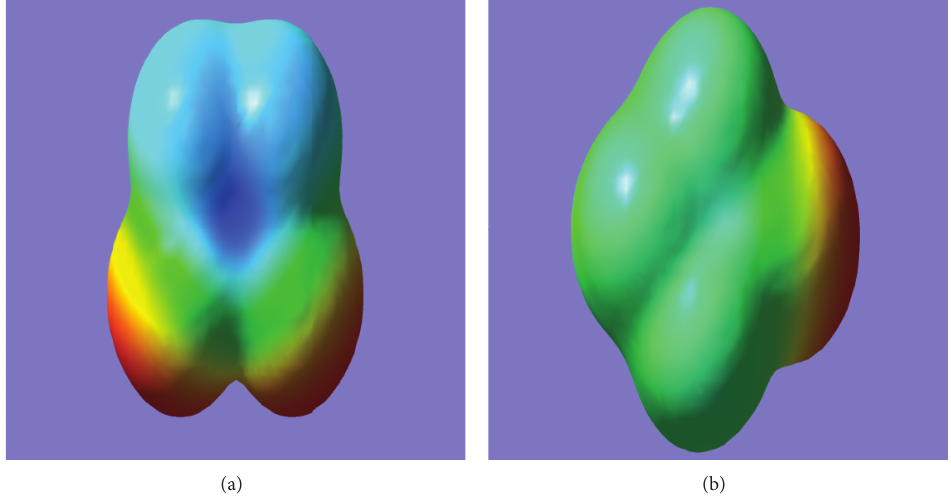
F 6: MESP pictures of 1,2-cyclobutanedione and cyclobutanone.